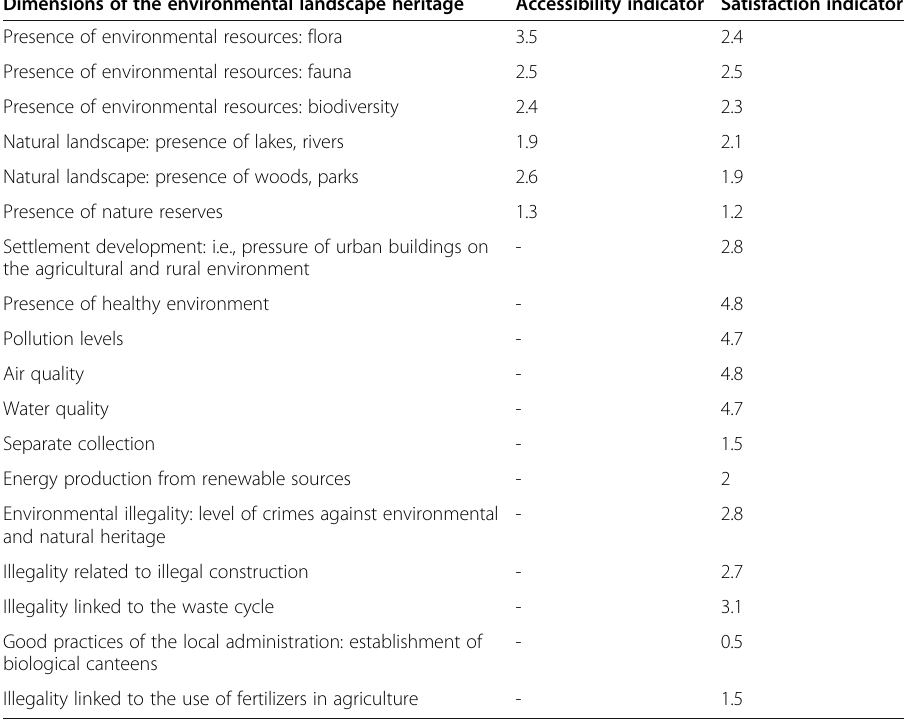
Table 5 Satisfaction indicators and accessibility indicators on the environmental landscape heritage detected by means of a quantitative survey (average scores, score expressed on a scale from 1 to